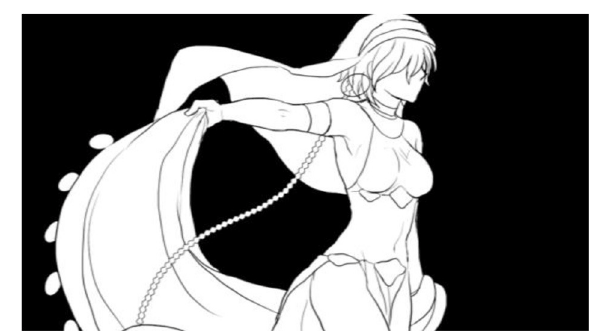
FIGURE 6 | Salome made in Japan (Vassiliadi, 2008), reproduced with the permission of the copyright holder (Sae Matsumura, Musashino Art University, Dino Sato, 2013, Art/European Animation